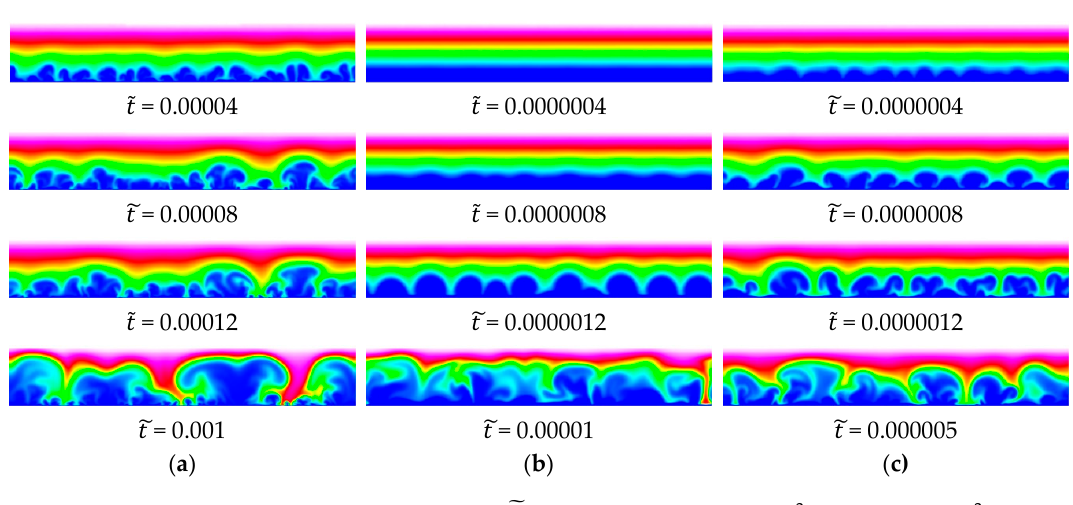
Figure 12. Two-dimensional simulations for (cid:101) V = 120 and ( a ) 10 mol/m 3 , ( b ) 100 mol/m 3 , and ( c ) 400 mol/m 3 . Smooth membrane. Anion concentration.